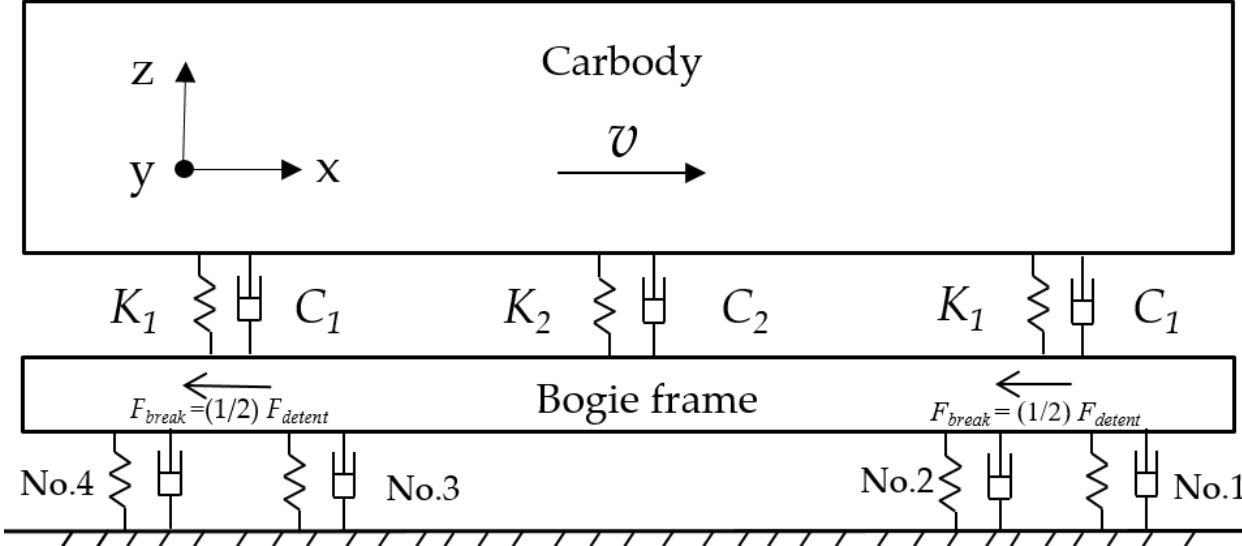
Figure 6. Schematic of location and number of maglev Dewars.